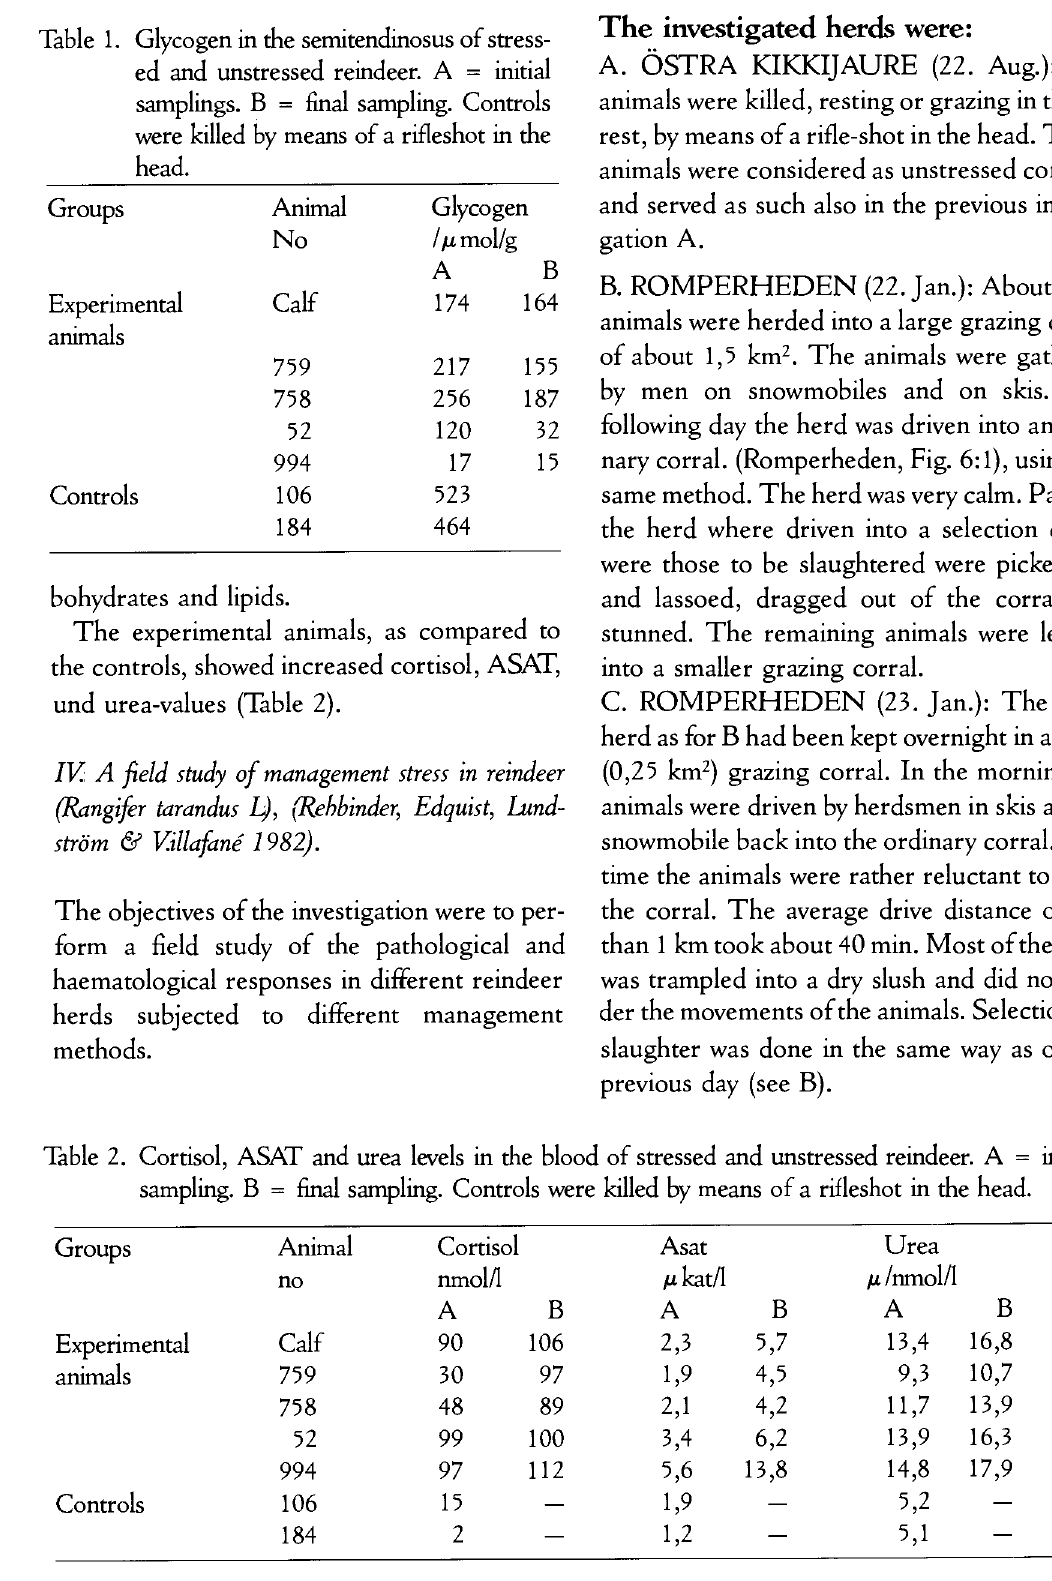
Table 1. Glycogen in the semitendinosus of stress ed and unstressed reindeer. A = initial samplings. B = final sampling. Controls were killed by means of a rifleshot in the head.